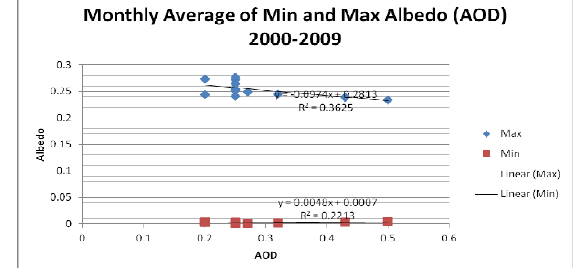
Figure 9. AOD and Albedo